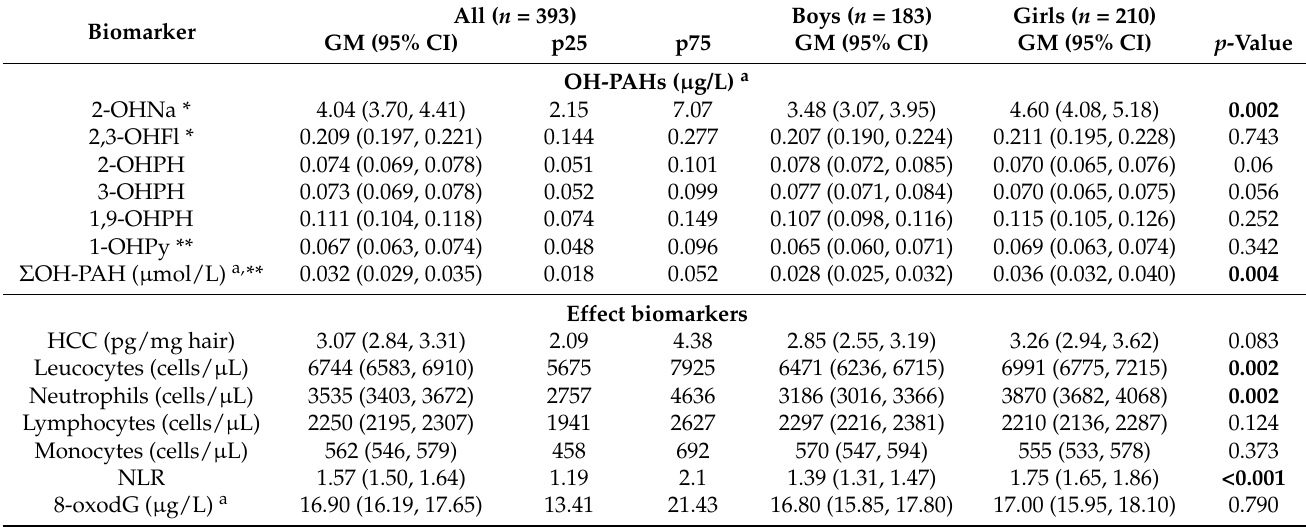
Table 2. Distribution of exposure and effects biomarker.